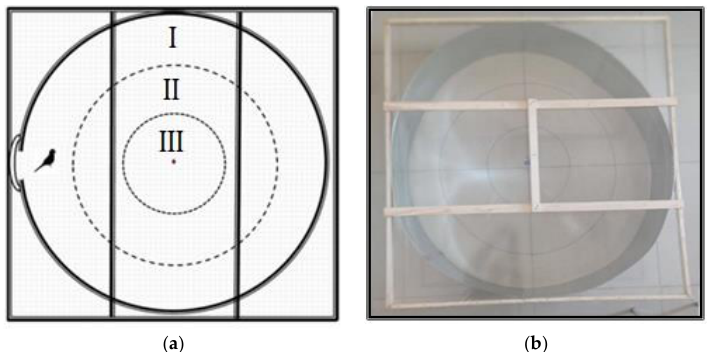
Figure 3. Behavioural analysis platform 1 (BAP I) for OFT I (( a ) diagram, ( b ) photo). I, edge of the platform; II, middle of the platform; III, centre of the platform.